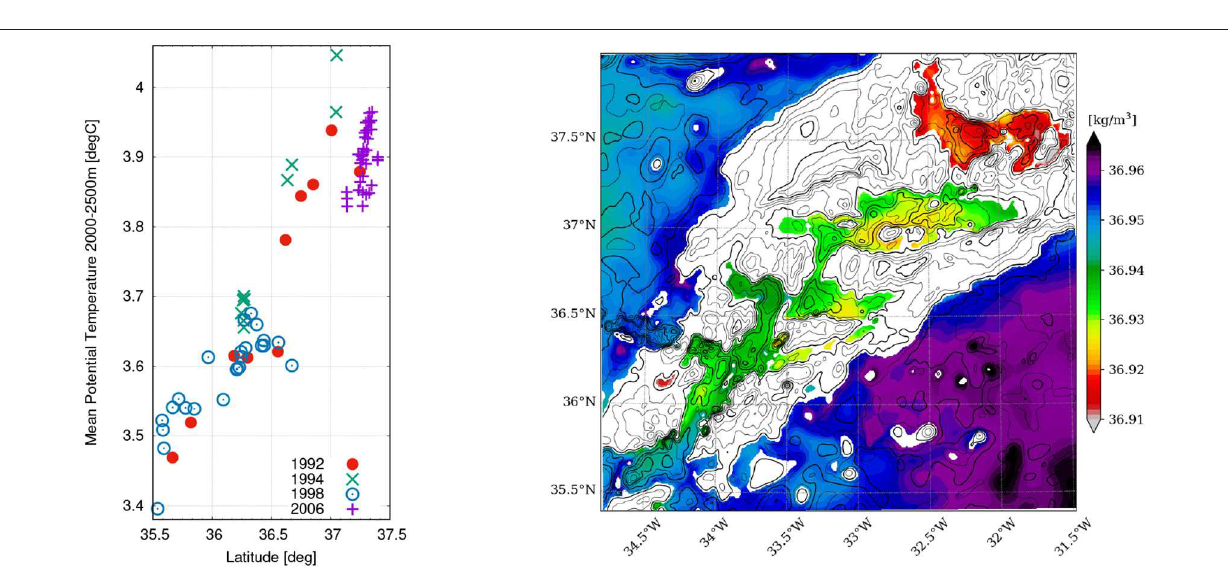
FIGURE 5 | (Left) Vertically averaged potential temperature in the rift valley between 2,000 and 2,500 m from four segment-scale surveys carried out in 1992, 1994, 1998, and 2006; only profiles extending below 2,300 m are shown. (Right) Mean potential density at 2,100 m from the numerical simulation. Topography contours (from the numerical model) are shown in black every 250 m (with a thick contour at 2,000